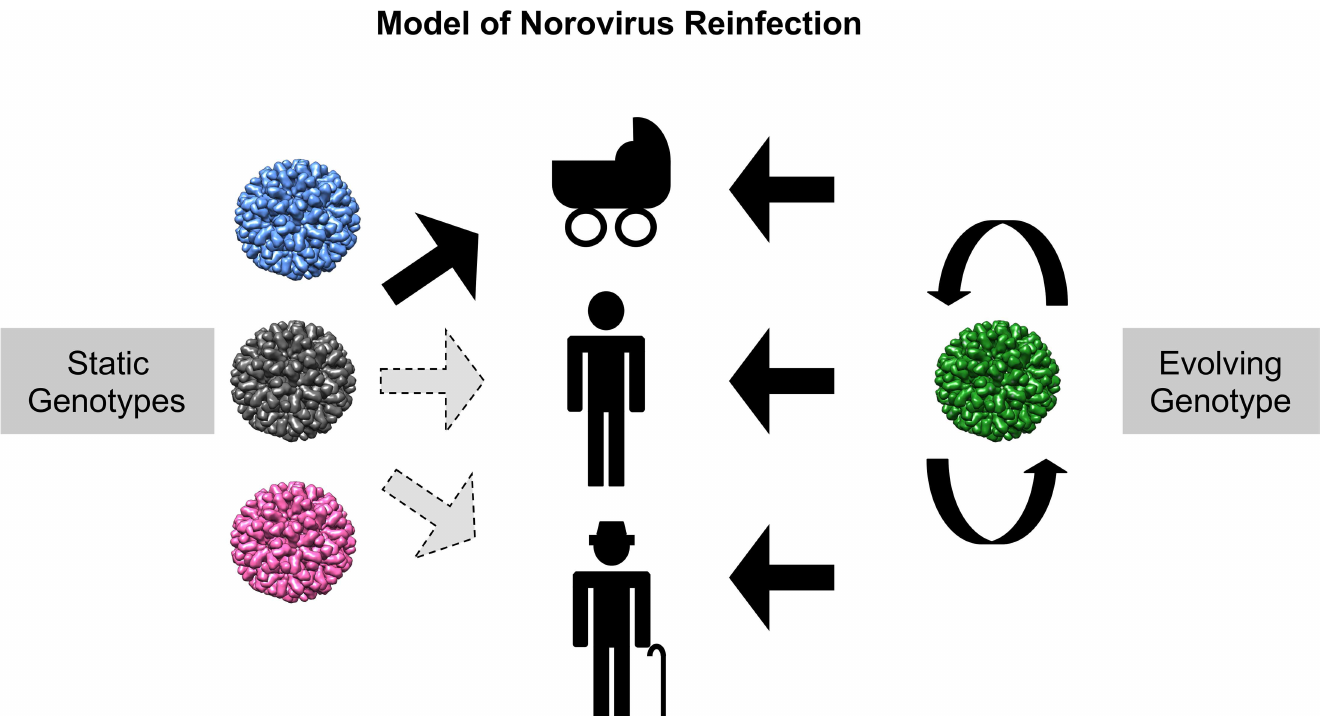
Fig 6. Model of norovirus evolution and infection. GII.4 noroviruses acquire phenotypic changesin their major capsid protein over time (evolving genotype), while non-GII.4 viruses retain a highly conservedcapsid protein for decades(static genotype). Clusteringof the different noroviruseshas shown the presenceof twelve groups(provisionally calledimmunotypes), with only one immunotypecontaining an evolvinggenotype(GII.4). Immunotypes represented by static genotypes can only re-infect individuals na ï veto that particularimmunotype,while the GII.4 evolvinggenotypecan re- infect individualsby periodicallyreplacing its variants. This model predicts that childrenare constantlyexposedand infected with strains from each of the different immunotypes(until a broad immunity develops),while older individualsare more likely to become ill from evolvinggenotypes. This model would explainthe epidemiological differencesreportedin the distributionof norovirusgenotypes in childrenand adults [17, 21, 37,